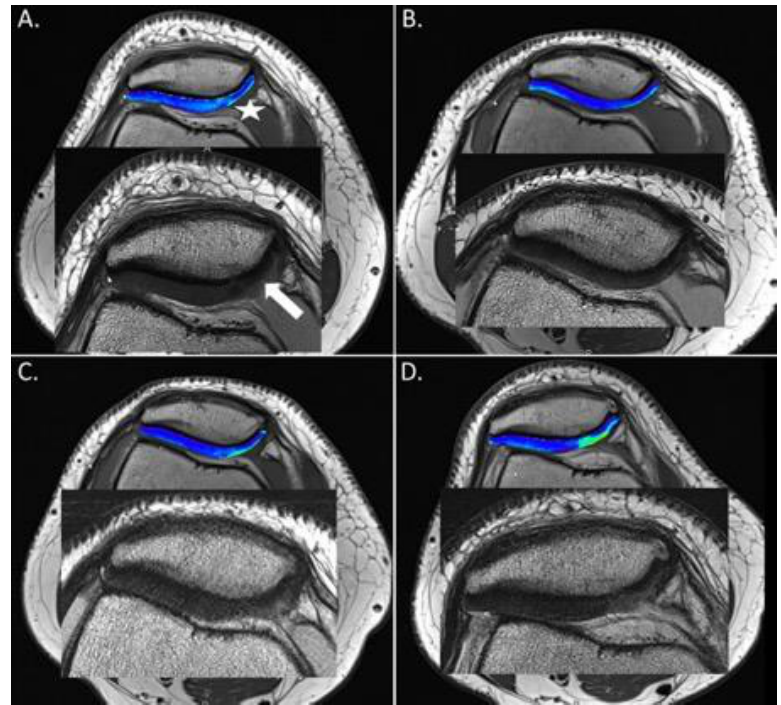
Figure 2. ( A ). Preoperative morphological magnetic resonance imaging (MRI) showing the International Cartilage Repair Society (ICRS) grade 2 cartilage defect at the medial facet of the patella (white arrow) and above the corresponding, color-coded T2 map. Note the increased T2 relaxation times of the defect, especially at the transition from the apex to the medial facet. (white star). ( B ) Two weeks postoperatively, the morphological MRI shows a full restoration of the cartilage surface including a hypointense area. The corresponding T2 map reveals a decrease in the T2 values compared to the preoperative status. ( C ) Four months and ( D ) twelve months postoperatively, the cartilage surfaces seem to break up and the corresponding T2 values increase significantly.